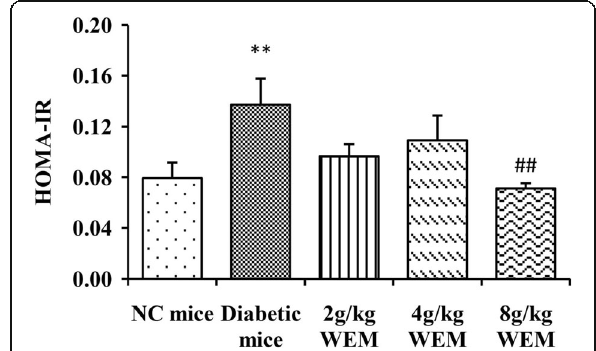
Fig. 1 Homeostasis model assessment of insulin (HOMA-IR) at the end of the trial. Results are means ± SEM ( n = 6). * P < 0.05, ** P < 0.01, NC mice vs. Diabetic mice; # P < 0.05, ## P < 0.01, WEM vs. Diabetic mice